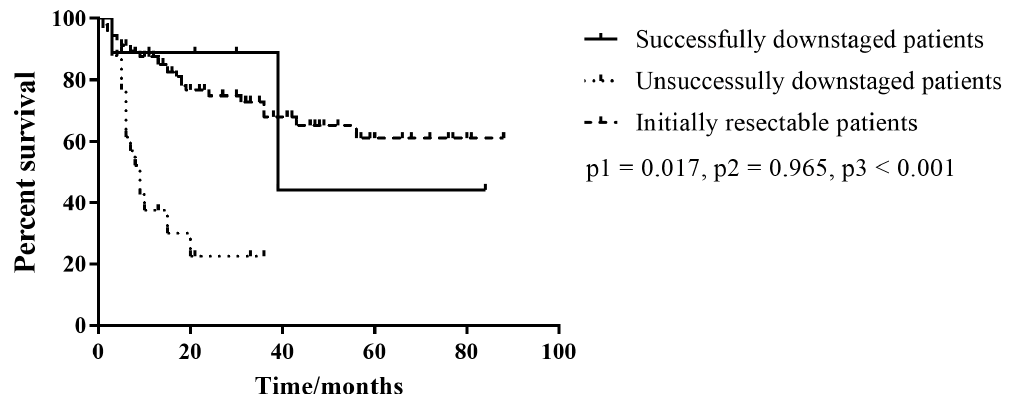
Figure 2. Kaplan–Meier curves comparing overall survival of successfully downstaged patients, unsuccessfully downstaged patients, and initially resectable patients based on the log-rank test. p1: successfully downstaged patients versus unsuccessfully downstaged patients; p2: successfully downstaged patients versus initially resectable patients; p3: unsuccessfully downstaged patients versus initially resectable patients.